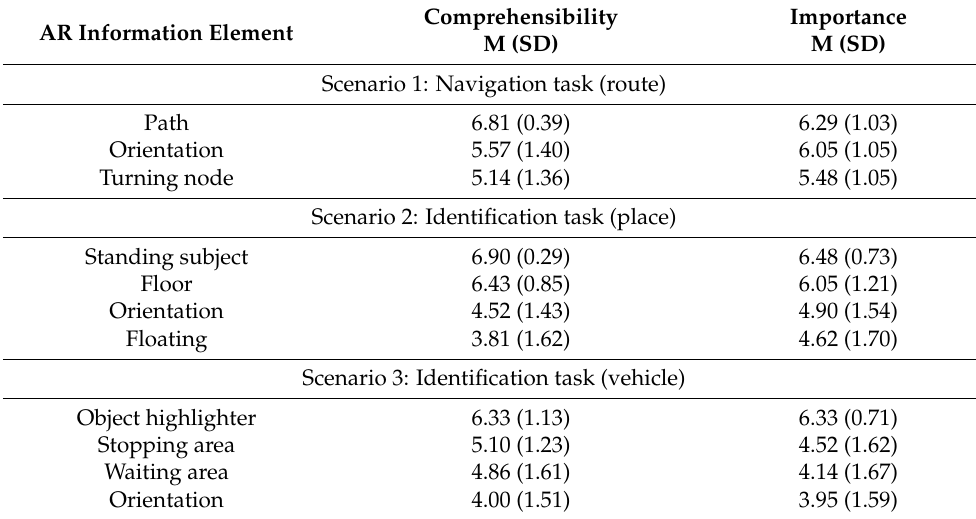
Table 1. Comprehensibility and importance rating of AR information elements by participants of the first user study (N =